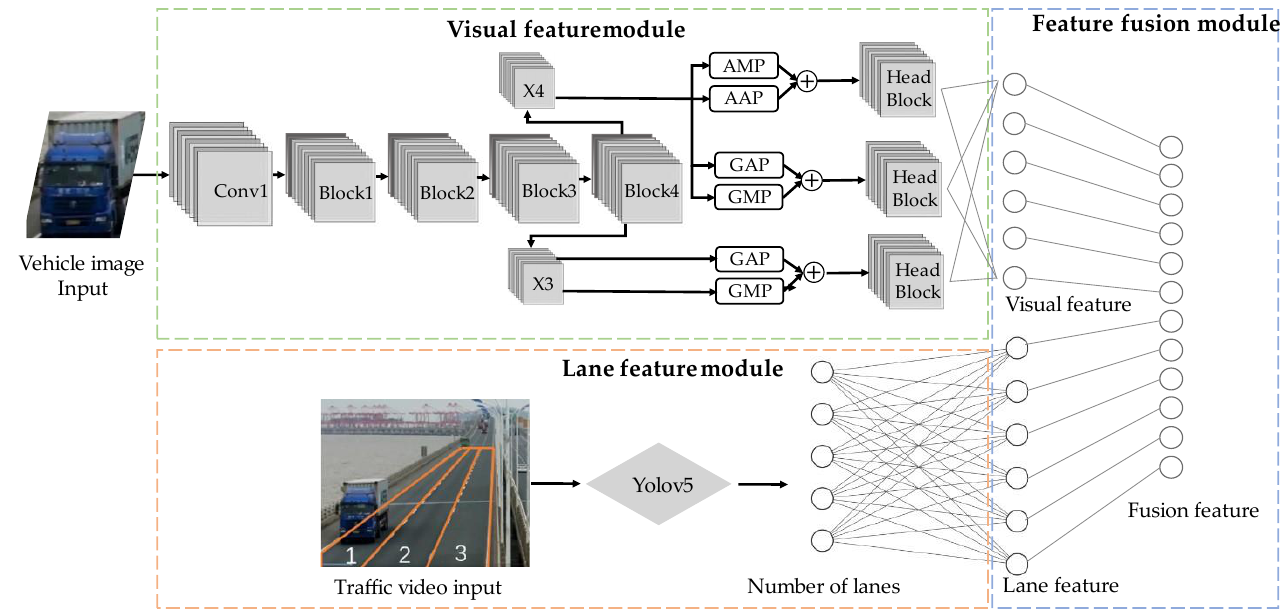
Figure 4. The structure of the vehicle re-identification model.